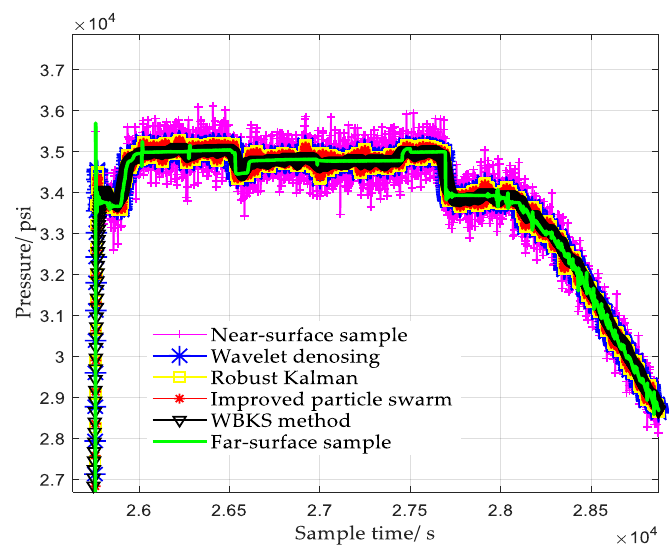
Figure 10. Output comparison under different processing methods.